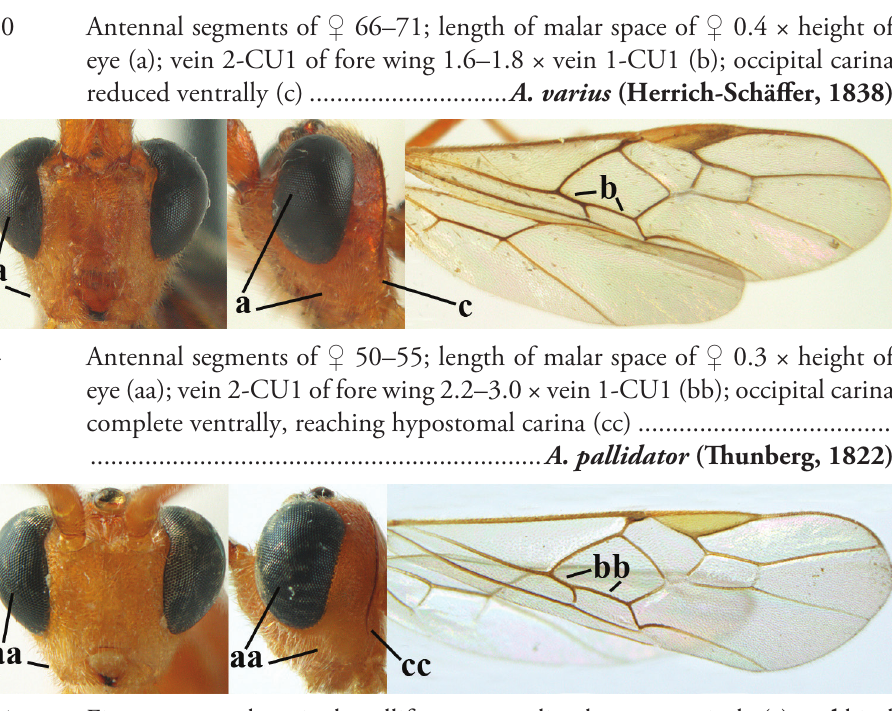
First metasomal tergite lamelliform protruding latero-anteriorly (a) and hind trochantellus of female slender, its ventral length 2.2–2.9 × its width (b); fore wing rather narrow (c); speculum of mesopleuron often rugose and with